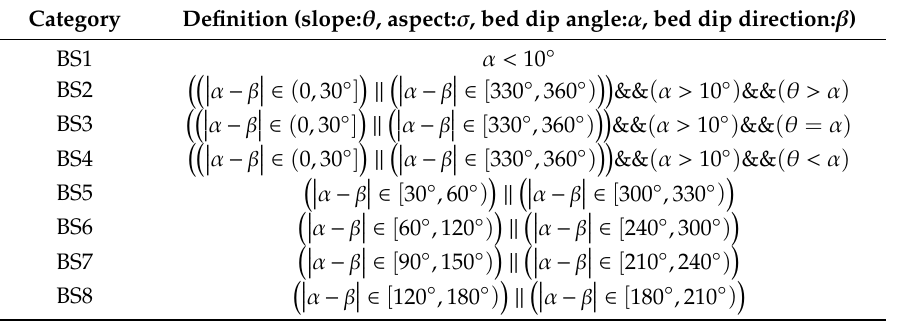
Table 3. Classification of bedding